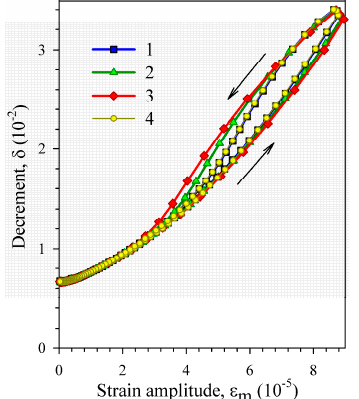
Figure 7. Strain amplitude dependence of the decrement of a Ni 50.8 Ti 49.2 sample, subjected to vacuum annealing No.4 (VA4), measured at 16 K in four consecutive runs with different measurement steps: 10% (1,4), 20% (2), 30% (3).